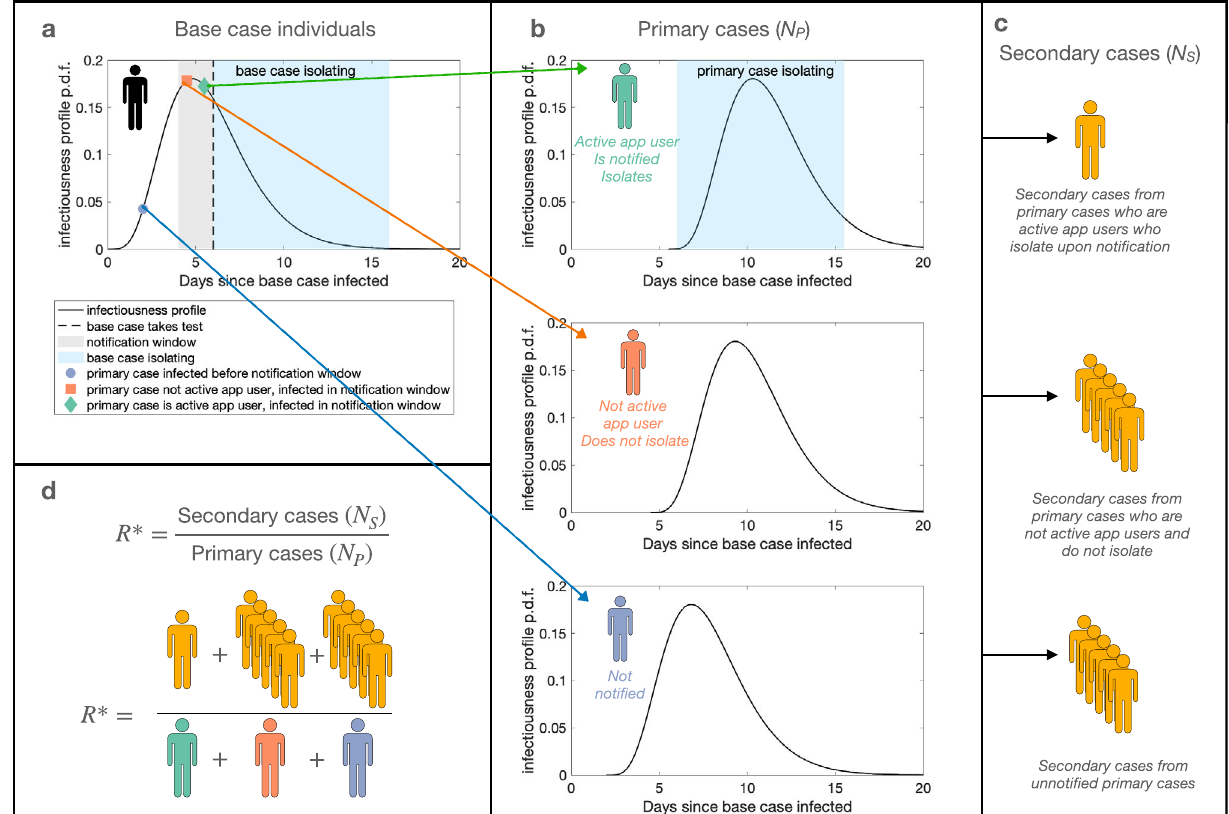
Fig. 1 Schematic illustrating the modelling approach. a The infectiousness of a base case individual varies through time. A base case individual takes a test on day d in their infectiousness pro fi le (dashed line), after which they isolate (light blue shaded area). b Primary cases with the app who are infected by the base case from day d − w to day d are noti fi ed of possible exposure. A proportion p of individuals infected within the noti fi cation window adhere to self- isolation (green, top panel), while a proportion (1 − p ) of individuals are not active app users and do not self-isolate (orange, middle panel). Adhering individuals self-isolate from noti fi cation until i notif days have elapsed since contact with the base case. Primary cases infected before day d − w are not noti fi ed (blue, bottom panel). Those who do not adhere to isolation upon noti fi cation or who are not noti fi ed either mix normally in the population throughout their infectious period or they isolate upon symptom onset. c The expected number of secondary cases resulting from non-adhering or unnoti fi ed primary cases is higher than the expected number of secondary cases that result from primary cases who adhere to isolation after noti fi cation. d R * is calculated as the ratio between the expected number of secondary cases and the expected number of primary cases — in our illustrative example, the expected number of secondary cases is 11, and the expected number of primary cases is 3, giving R * =